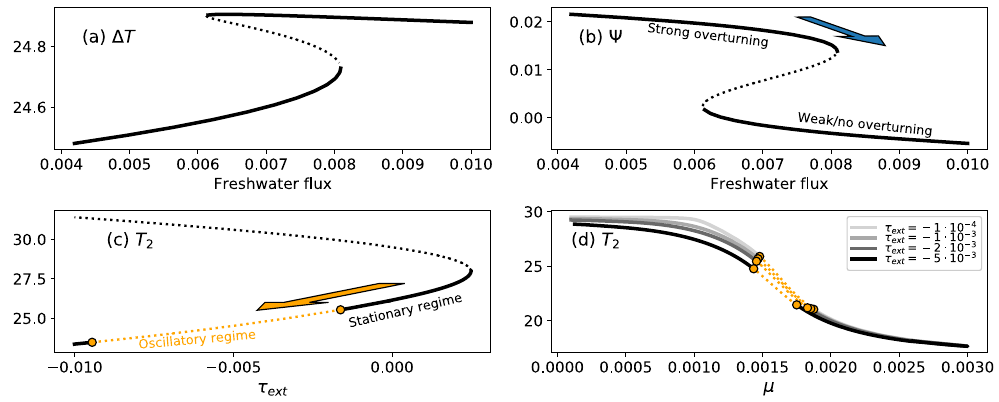
Figure 8. Bifurcation diagrams and forward runs of the Stommel (a, b) and Timmermann (c, d) models. The blue arrow indicates the collapse of the overturning circulation, which (negatively) amplifies the external zonal wind stress in the Pacific τ ext , such that the system enters an oscillatory state. The orange arrow indicates subsequent tipping in the following (ENSO) system. (a) Meridional temperature gradient equilibria versus freshwater flux, and (b) non-dimensional stream function versus freshwater flux. These figures show the multiple states of the overturning. (c) Eastern equatorial Pacific SST versus τ ext (for µ = 0 . 00145), showing a regime where the system is stationary and a regime where the system is oscillatory; (d) eastern equatorial Pacific SST versus µ for different values of τ ext . Orange dots indicate Hopf bifurcation points, and orange dotted lines indicate oscillatory regimes. Black and grey solid lines indicate stable equilibria, and black dashed lines indicate unstable equilibria.